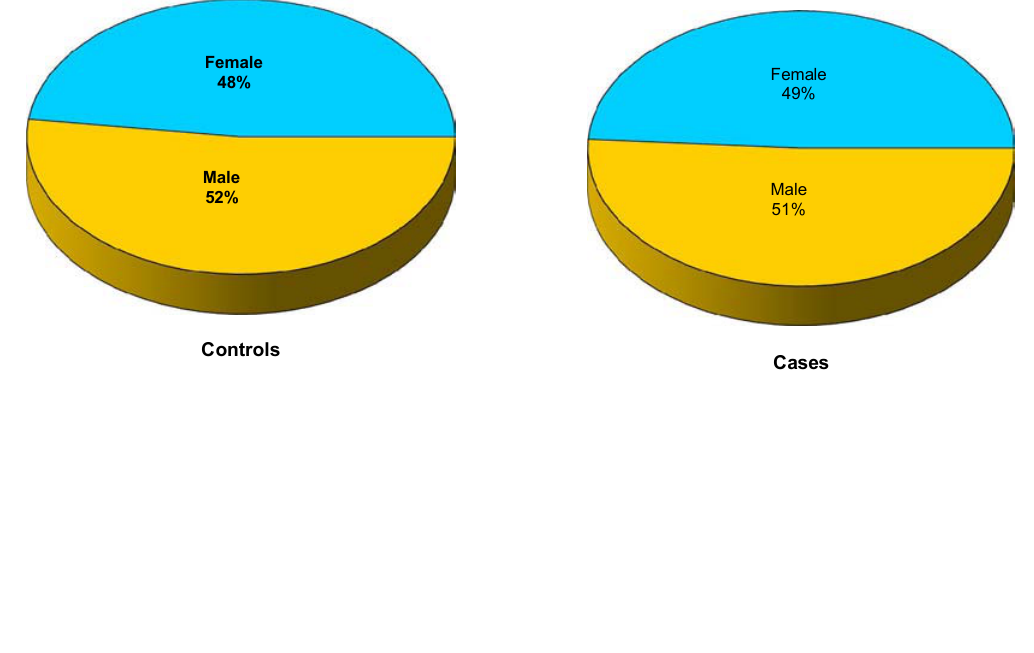
Figure 2: Gender distribution of subjects